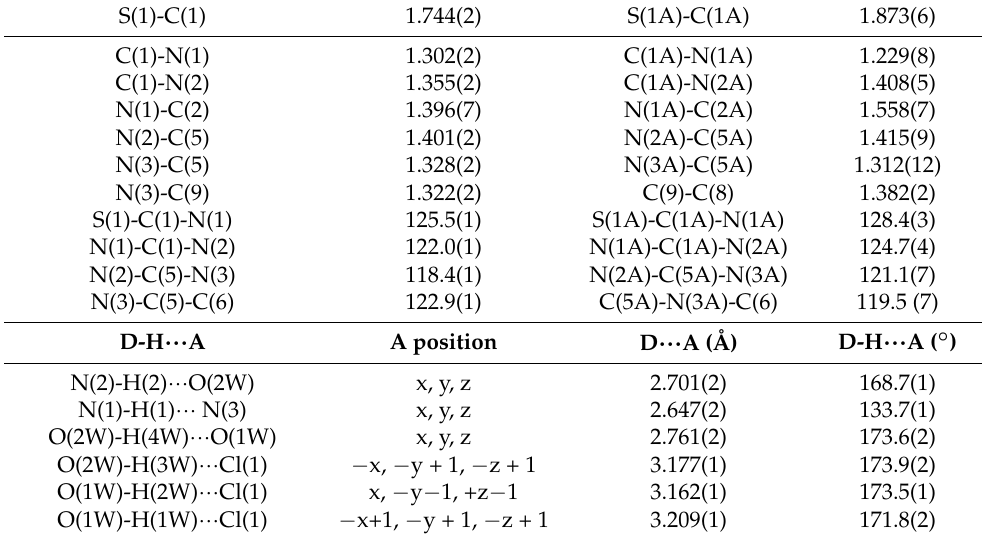
Figure 1. ( a ) Crystal structure and numbering system of majority arrangement for PyTzHCl·2H 2 O, ( b ) Resolution of static disorder in the crystal structure and numbering system for PyTzHCl·2H 2 O. Table 1. Selected bond lengths (Å), angles (°) and hydrogen-bond parameters for PyTzHCl·2H 2 O.